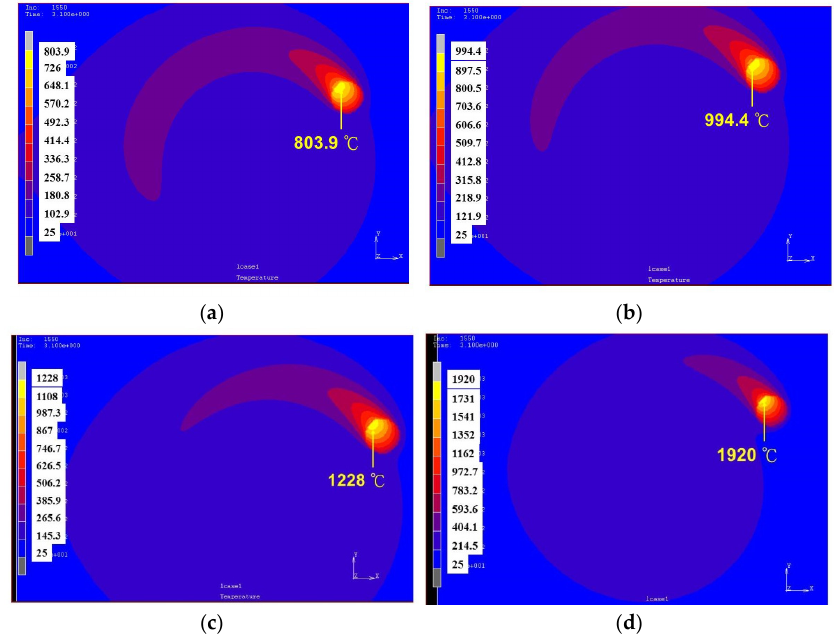
Figure 7. Temperature variation for the laser quenching processes with different powers. ( a ) 500 W, ( b ) 600 W, ( c ) 700 W, and ( d ) 900 W The numerical results of the temperature variation by the FEA and measurements are shown in Figure 8. According to the arrangement of the thermocouples as shown in Figure 4, the measuring point of the temperature was located at the distances of 1 mm and 1.5 mm away from the laser spot. At a laser power of 900 W, it was found that the ther- mocouple couple lost its contact at the welding point for which the comparison chart is not portrayed. In Figure 8, according to the FEA results at the measuring position, the maximum temperatures were around the values of 240 °C, 275 °C, and 315 °C for laser powers of 500 W, 600 W, and 700 W, respectively. For the experimental results, the tem- perature variation was vigorous when the laser spot was around the measuring point. The difference between the FEA and experimental results may be attributed to the distance between the measuring point and captured measurement data frequency. The experi- mental and simulated captured frequencies were 300 Hz and 100 Hz, respectively. The acquisition frequency was reduced during the simulation to reduce the huge quantity of data and save computing time. Therefore, the temperature field results obtained were rel- atively smooth. The experimental data showed that the temperature increased when the laser approached the measurement point and decreased when it moved away. According to the experimental results, as shown in Figure 8a,b, the maximum temperatures were 370 °C and 300 °C for the a laser power of 500 W with an offset of 1 mm and 600 W with an offset of 1.5 mm, respectively. In addition, as shown in Figure 8b,c, the maximum temper- atures were 300 °C and 640 °C for laser powers of 600 W and 700 W with the same offset of 1.5 mm. The experimental results showed that the maximum temperature in the vigor- ous variation region was strongly affected by the laser power and the offset between the thermocouple and the laser spot.